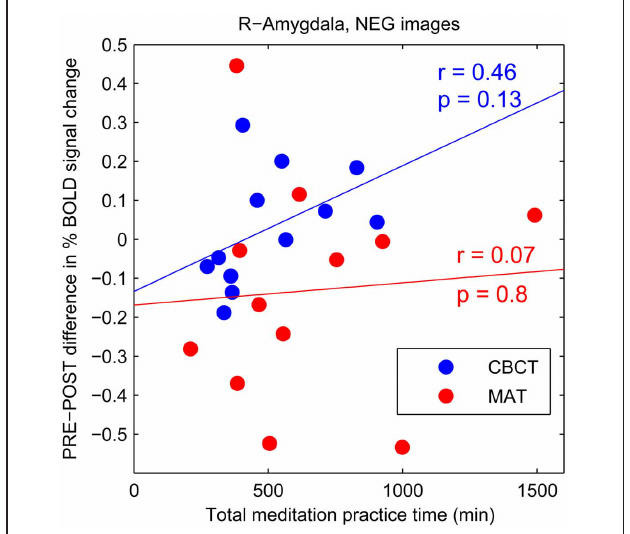
FIGURE 4 | PRE-POST difference in depression score as a function of PRE-POST difference in percentage BOLD signal change in right amygdala. Each data point corresponds to an individual subject. The CBCT group is shown in blue, the MAT group in red. Linear regression lines are shown in corresponding